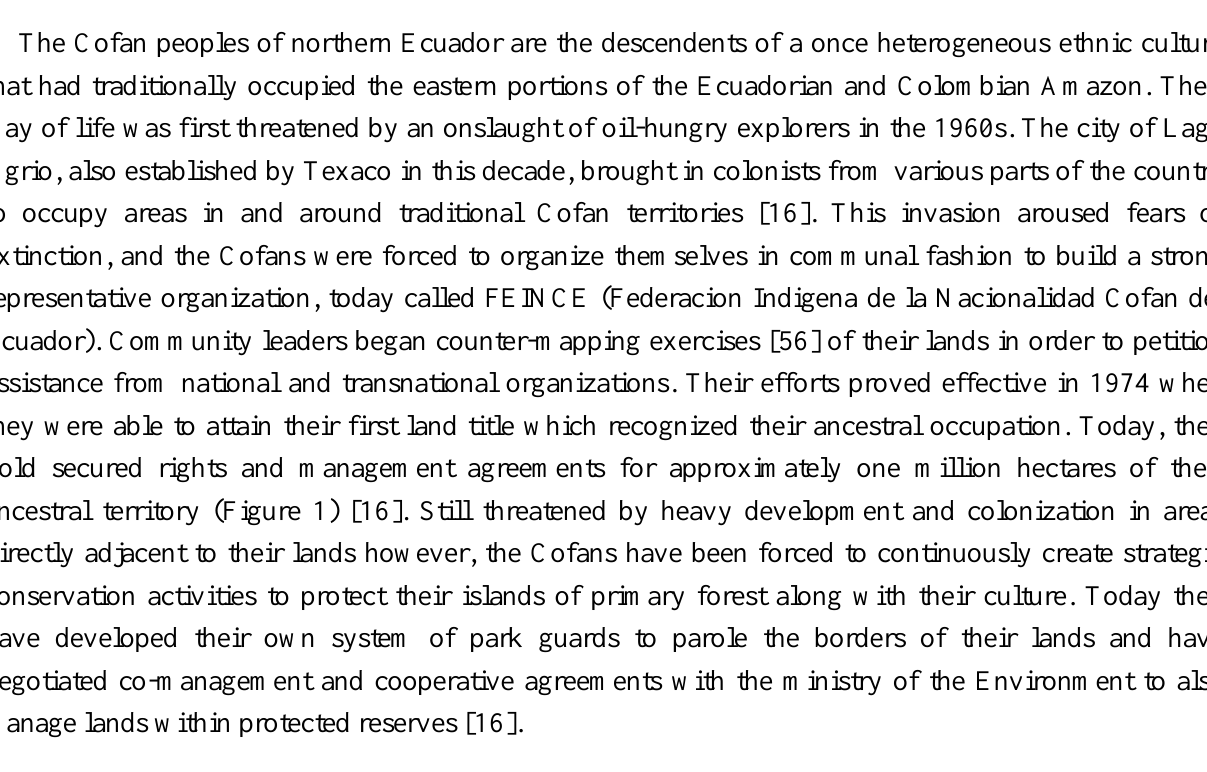
Figure 1. Territory managed by the Cofan Indian nation in Ecuador (in gray). Adapted from